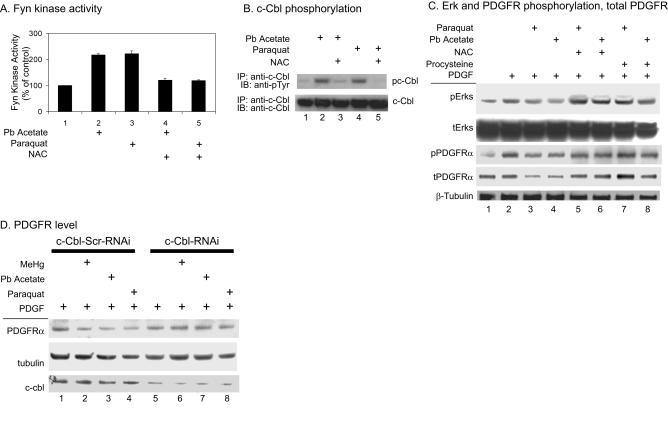
Pb and Paraquat Exposure Caused Activation of Fyn and c-Cbl, Suppression of ERK1/2 Phosphorylation, and Reduction in Levels of PDGFRα(A) Purified O-2A/OPCs were treated as for analysis of MeHg, except that cells were exposed to 1 μM Pb or 5 μM paraquat. Both toxicants caused activation of Fyn, analyzed as in Figure 5.(B) Pb and paraquat exposure also caused phosphorylation of c-Cbl, as detected by immunoprecipitation of total c-Cbl followed by analysis with anti-phosphotyrosine antibody.(C) Pb and paraquat exposure cause suppression of ERK1/2 phosphorylation and reductions in total levels of PDGFRα.(D) Expression of c-Cbl RNAi caused a reduction in levels of c-Cbl protein and protected PDGFRα levels from effects of MeHg, Pb, and paraquat, whereas scrambled (Scr) RNAi constructs had no levels of PDGFRα. NAC (or procysteine, a cysteine pro-drug with no intrinsic anti-oxidant activity) protected against all effects of toxicant exposure.All experiments were repeated at least three times. The plus symbol indicates exposure of the cells to the indicated substance.